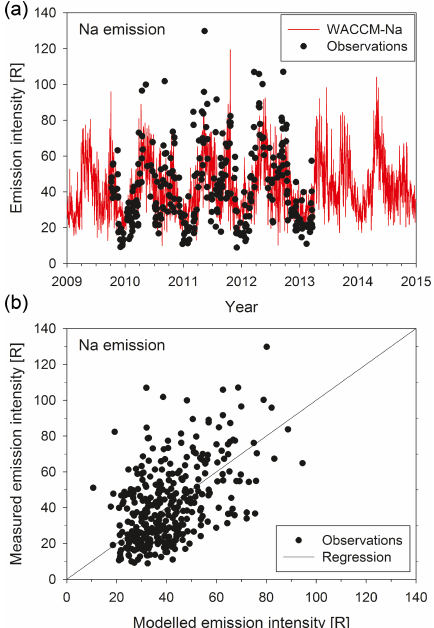
Figure 6. Comparison of the measured and modelled FeO emis- sion intensity. (a) Absolute intensities over the period 2009–2015. (b) Correlation between the measured and modelled intensities. Note that the modelled intensities are scaled to produce a 1:1 re- gression line through the origin.